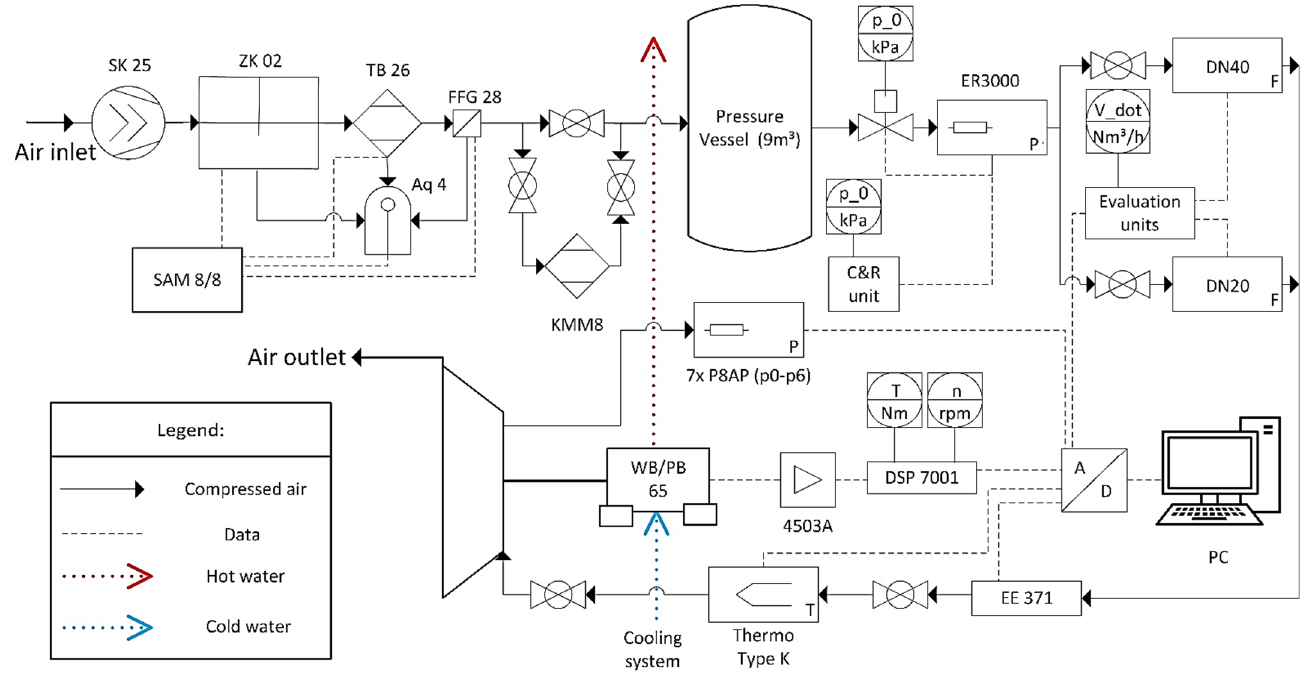
Figure 7. Structure of the test facility for compressed air drives and technology ( PDLT ).